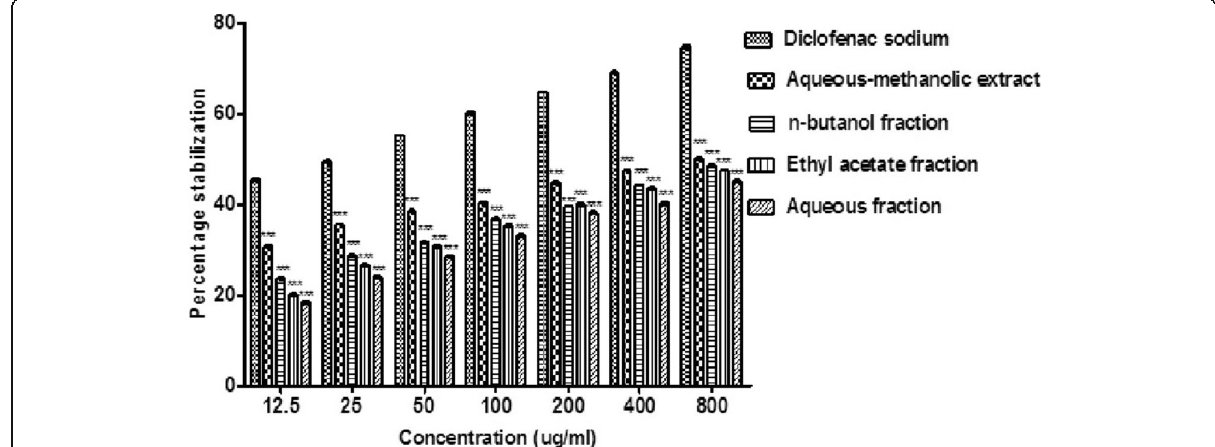
Fig. 3 Effect of B. orthobotrys aqueous-methanolic extract and fractions on membrane stabilization. All the values are expressed as mean ± SEM ( n = 3), using two way ANOVA followed by Bonferroni posttest. *** = p < 0.001 vs diclofenac sodium